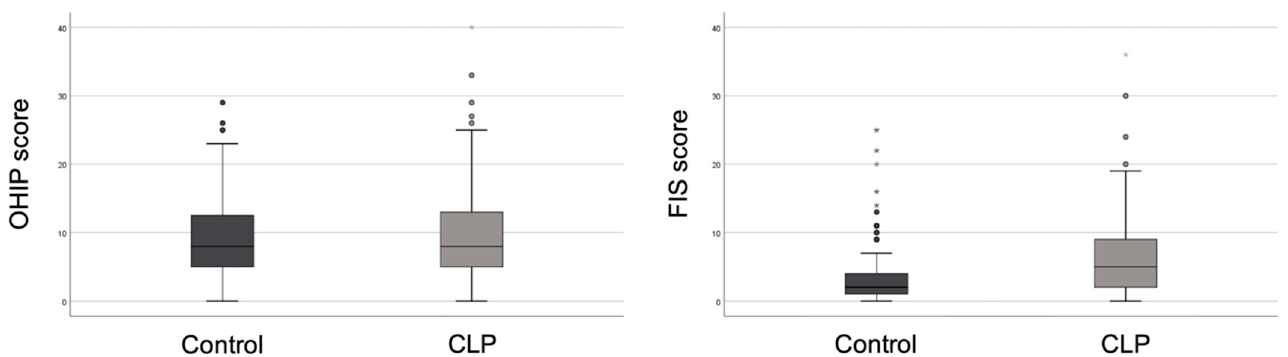
Figure 1. Distribution of values in OHIP and FIS scores.